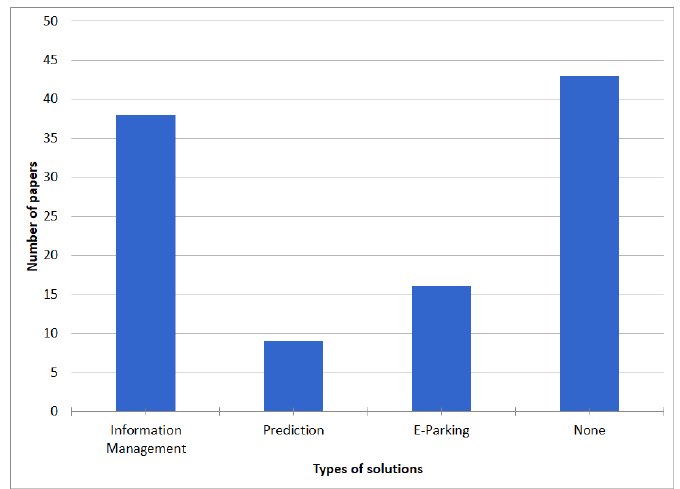
Figure 8. Software Solutions of smart